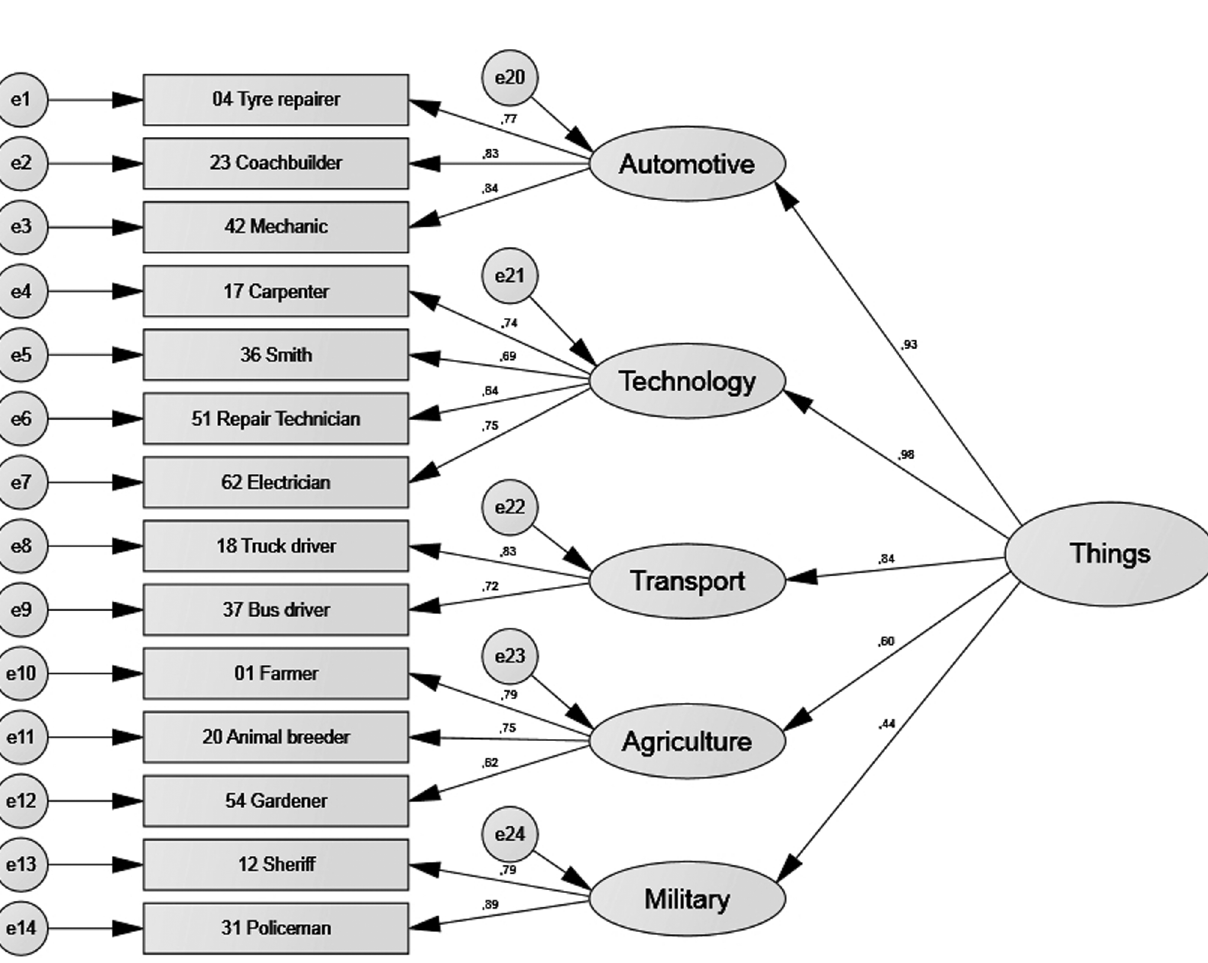
Figure 2. Standardised estimates for the things